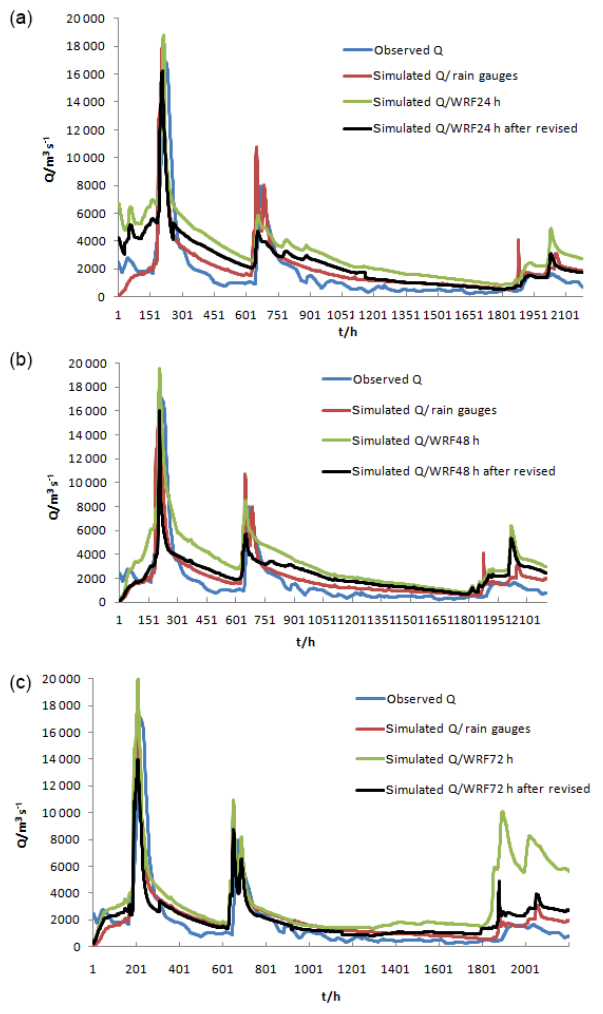
Figure 9. Coupled flood simulation results with the original model parameters (2013). (a) is the simulated result with 24h lead time, (b) is the simulated result with 48h lead time, and (c) is the simu- lated result with 48h lead time.